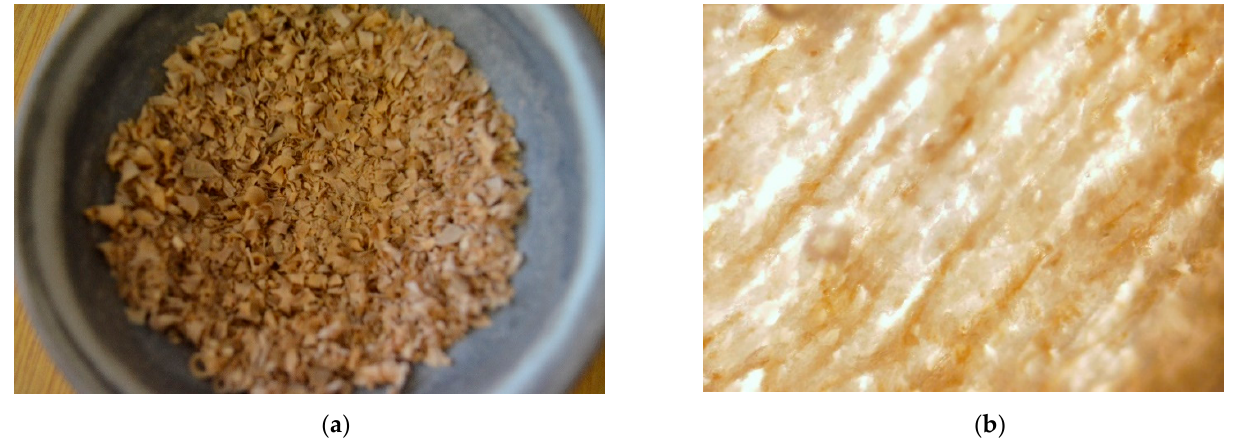
Figure 1. ( a ) Wood chips used in this study, and ( b ) image of the surface of the wood chips (magnification of 80×). Harvested wood was chopped into 5–10 cm pieces and grinded with a mill. Fractions